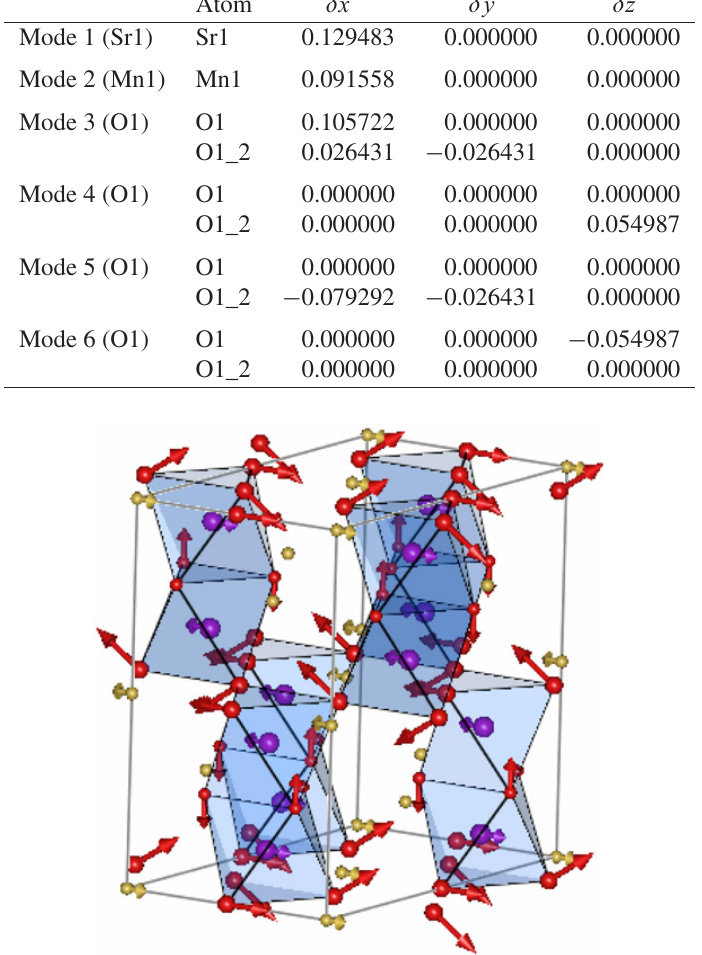
Figure 10. Polarization vector in an arbitrary scale of the GM5 − distortion that describes the refined C 222 1 structure of SrMnO 3 (figure done with FullProf Studio